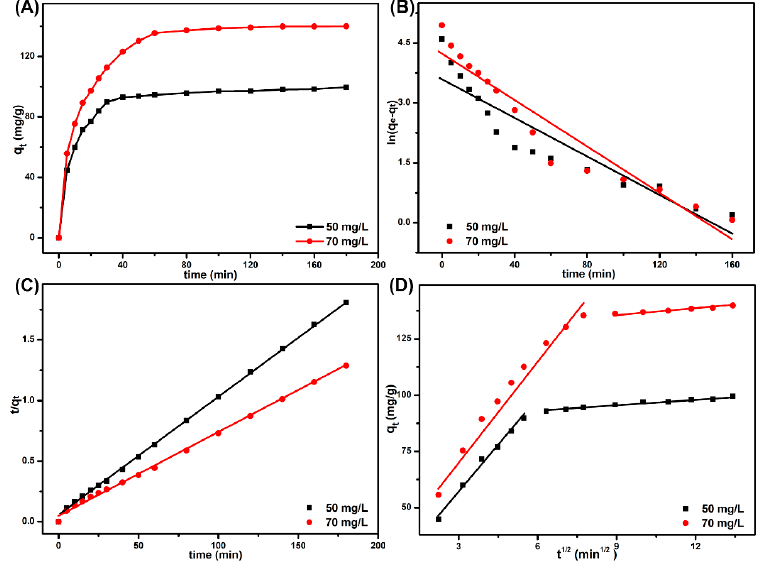
Figure 7. Effect of contact time on MB adsorption capacity ( A ), pseudo-first-order ( B ), pseudo-second-order ( C ) and intraparticle diffusion ( D ) for the adsorption of MB onto SPEN-Al-2.